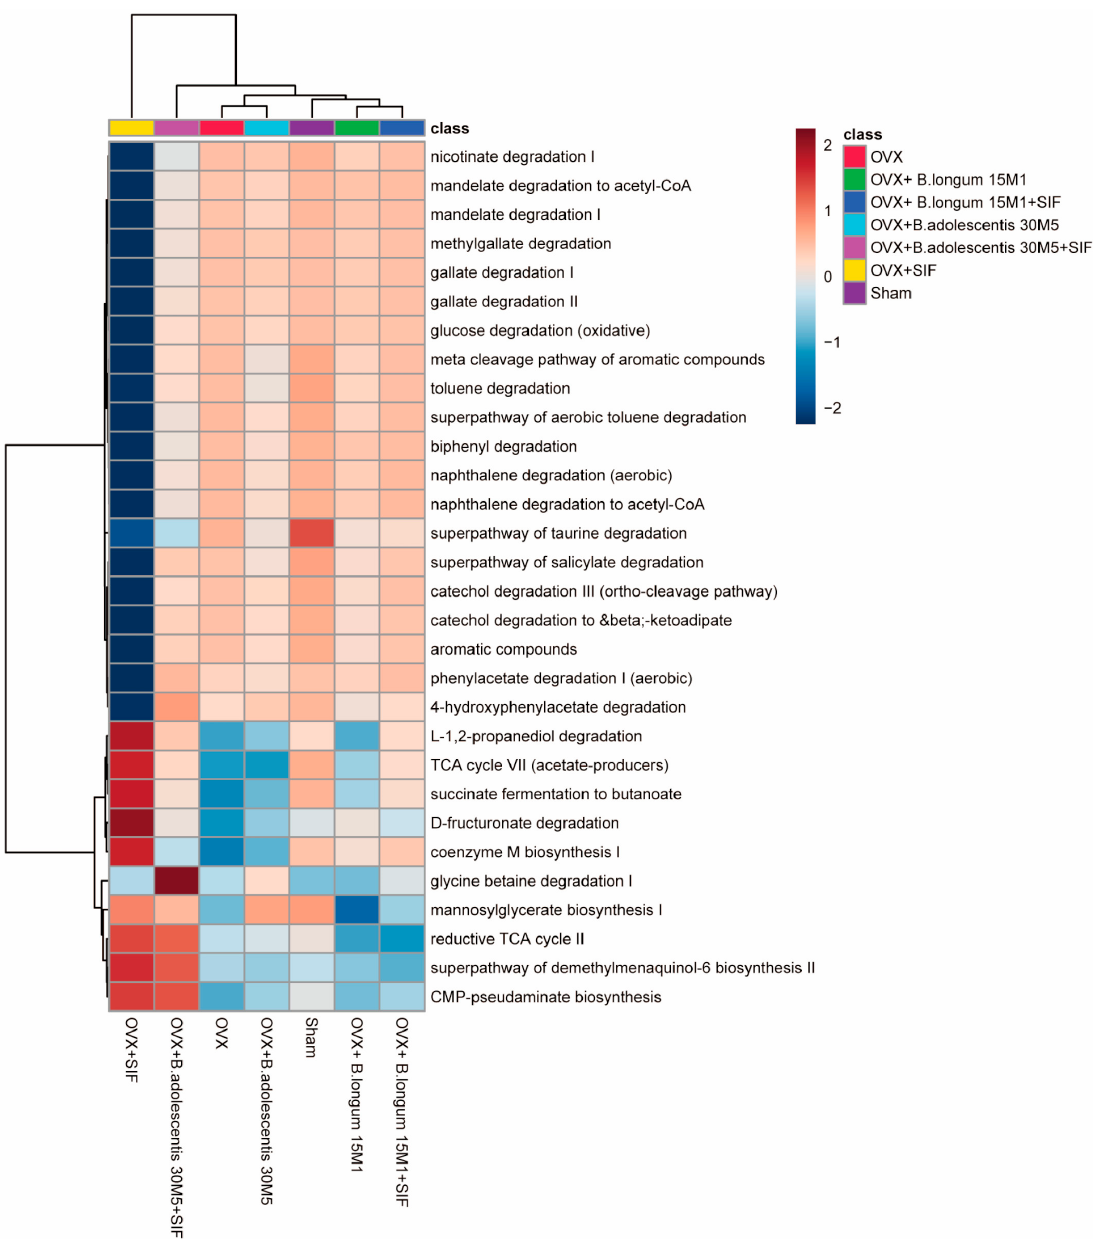
Figure 7. Heatmap of the differential pathways predicted by PICRUSt 2 (phylogenetic investigation of communities by reconstruction of unobserved states).